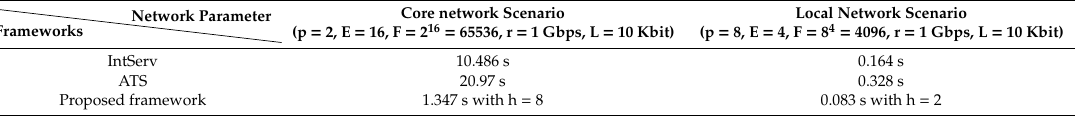
Table 2. Performance comparisons of the IntServ, the ATS, and the proposed framework.